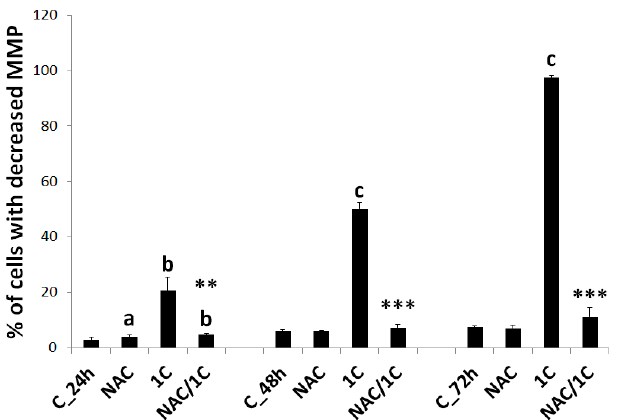
Figure 8. Mitochondrial membrane potential changes after 1C or NAC/1C treatment. Significantly different b p < 0.01, c p < 0.001 vs. untreated cells (control); ** p < 0.01, *** p < 0.001 vs. 1C.